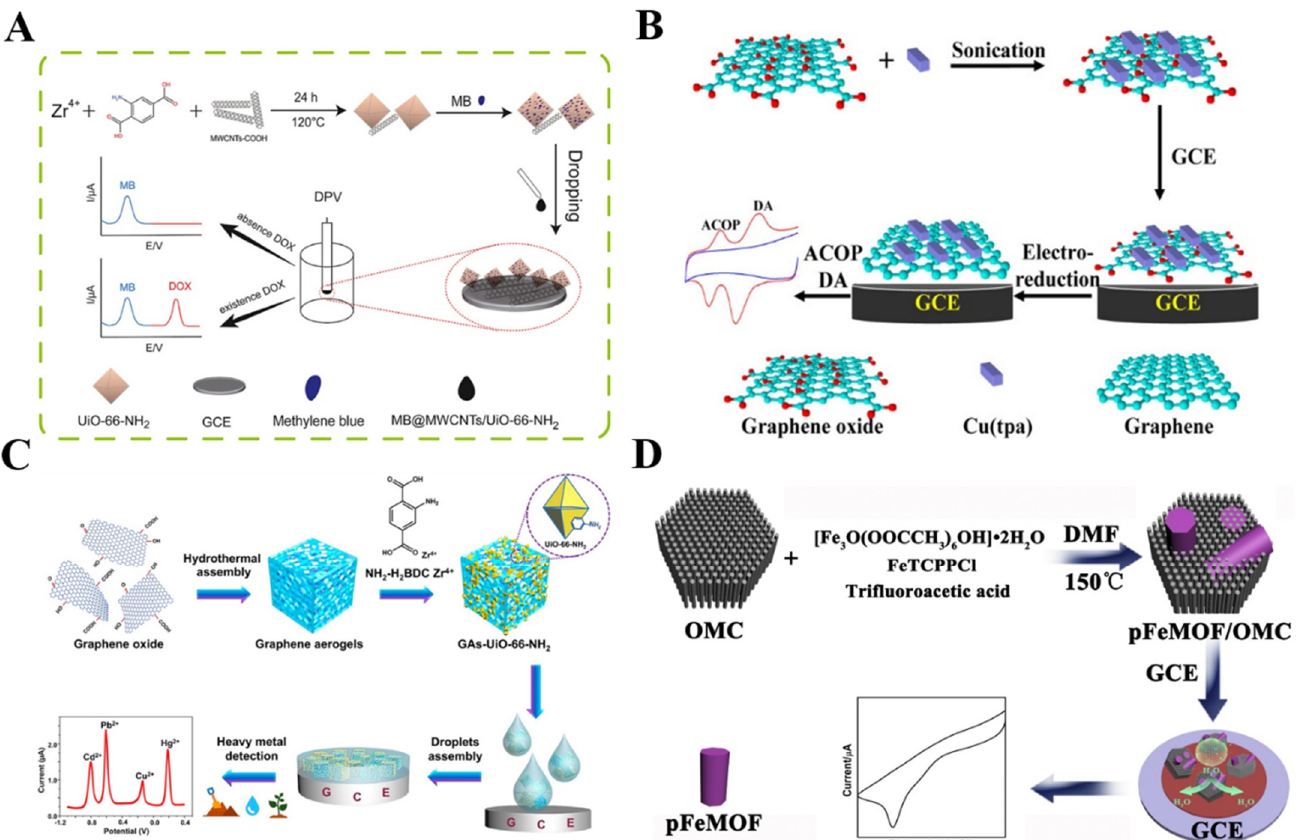
Figure 2. ( A ) Schematic illustration of a ratiometric electrochemical sensor for the determination of doxorubicin, based on MB − loaded MWCNTs/UiO-66-NH 2 . Reprinted with permission from Ref. [89]. Copyright 2022, Elsevier. ( B ) Schematic illustration of the ultrasonication-assisted preparation of Cu(tpa) − GO and the simultaneous determination of ACOP and DA. Reprinted with permission from Ref. [92]. Copyright 2014, American Chemical Society. ( C ) Schematic illustration of the preparation of GAs-UiO-66-NH 2 and the simultaneous detection of heavy-metal ions by a GAs − UiO-66-NH 2 modified electrode. Reprinted with permission from Ref. [95]. Copyright 2019, American Chemical Society. ( D ) Schematic illustration of the preparation pathway of pFeMOF/OMC samples. Reprinted with permission from Ref. [99]. Copyright 2017, Elsevier.